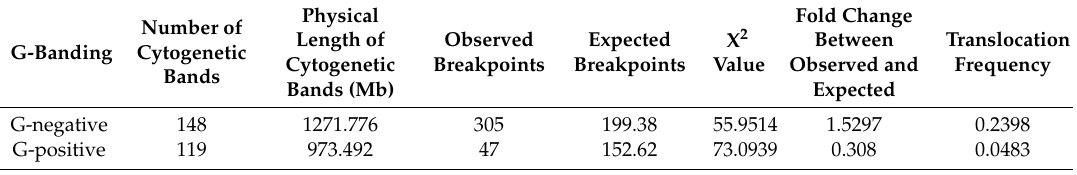
Table 6. Comparison of translocation breakpoints on G-negative and G-positive cytogenetic bands.